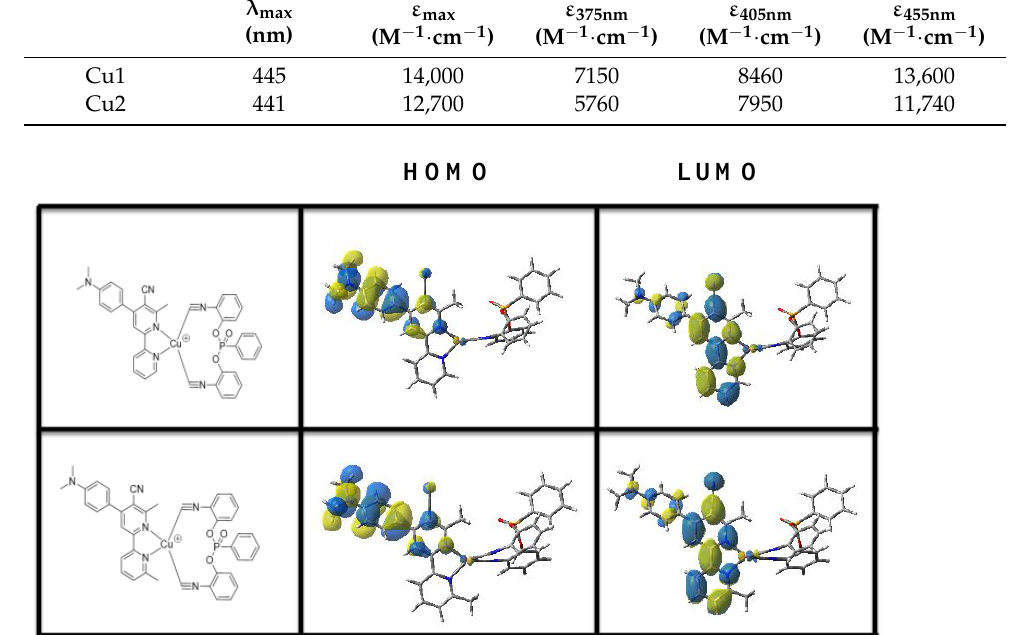
Figure 3. UV ‐ visible absorption spectra of ( 1 ) Cu1 and ( 2 ) Cu2 in DCM. Table 1. Maximum absorption wavelengths (λ max ), extinction coefficients at λ max , and molar extinc- tion coefficients for the investigated copper complexes at different emission wavelengths for different LEDs used.